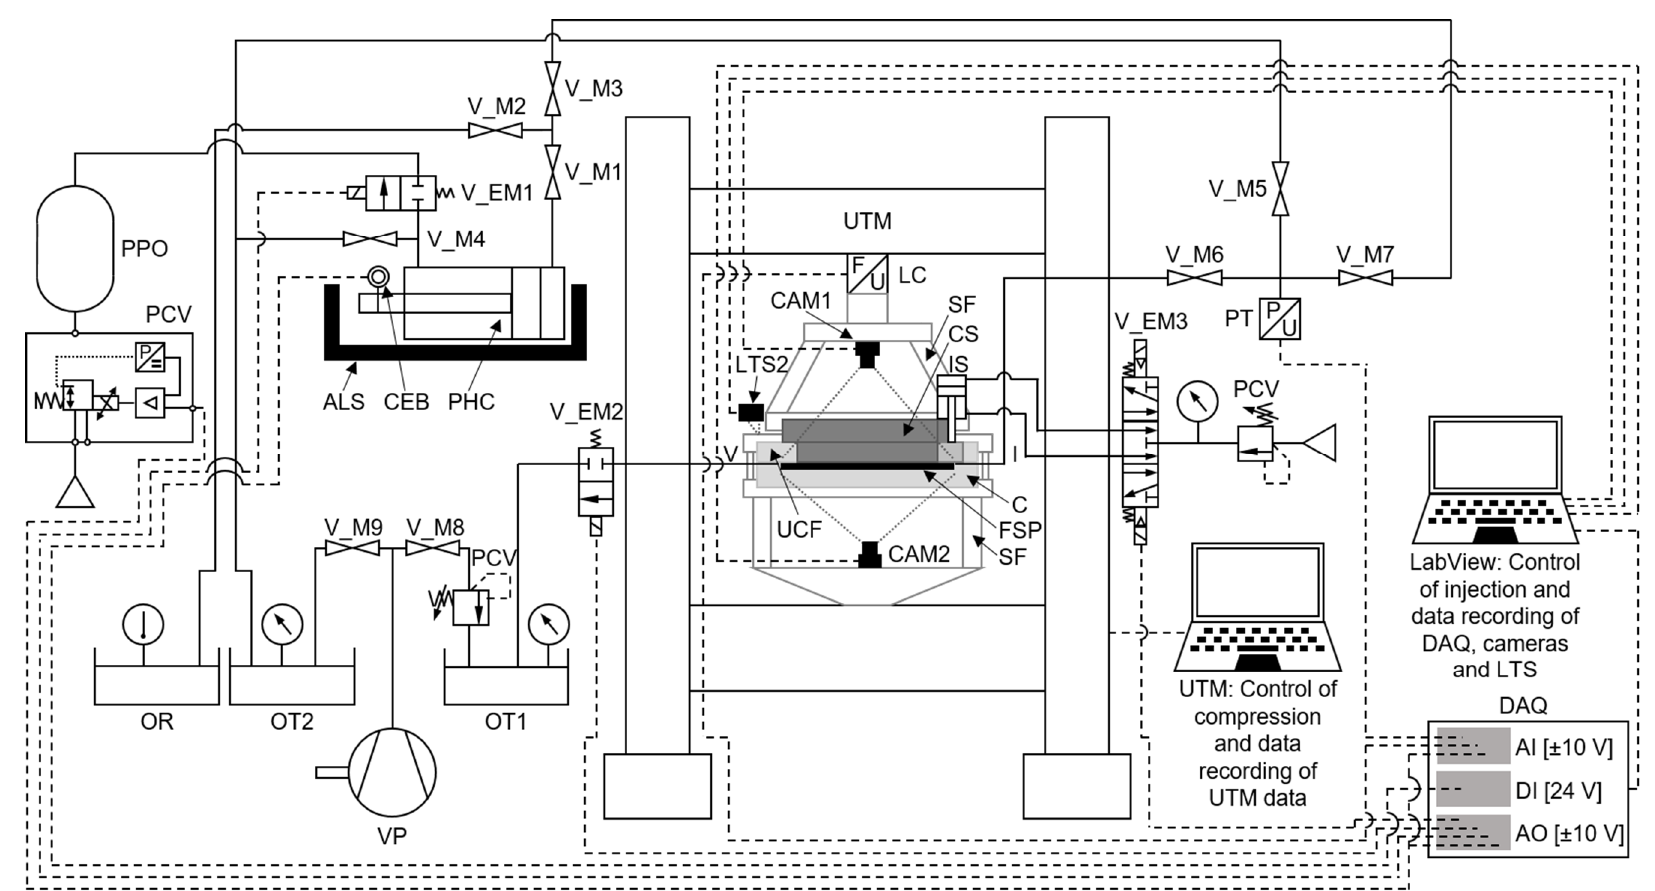
Figure A1. Schematic of flow visualization test rig. For a list of abbreviations and further details, see Table A1.